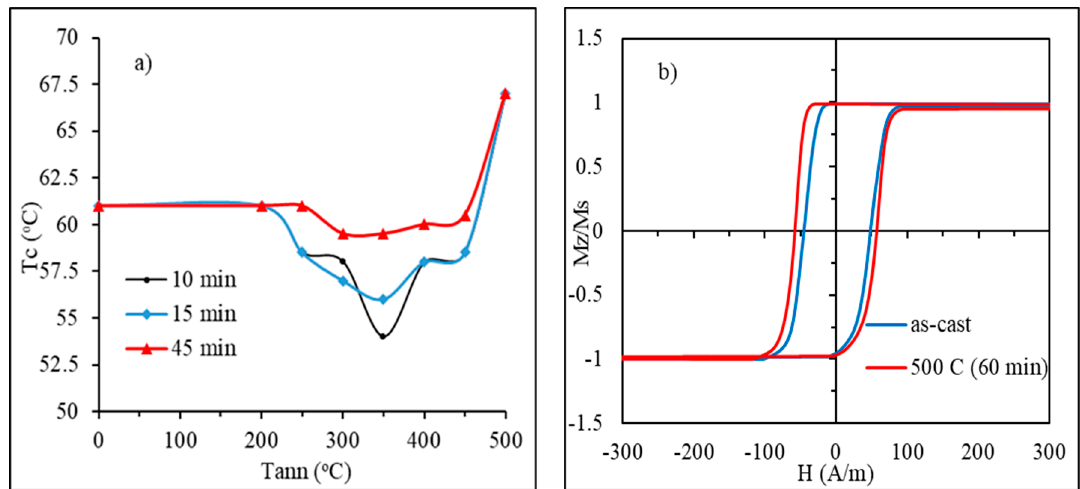
Figure 9. Effect of annealing on the Curie temperature and hysteresis loops for amorphous Fe 3.9 Co 64.82 B 10.2 Si 12 Cr 9 Mo 0.08 microwire (in as-prepared state T c = 61.5 °C). In ( a ), T c vs. annealing temperature for different annealing times; in ( b ), the hysteresis curves in the as-prepared state and after annealing with a high annealing temperature of 500 ℃ .